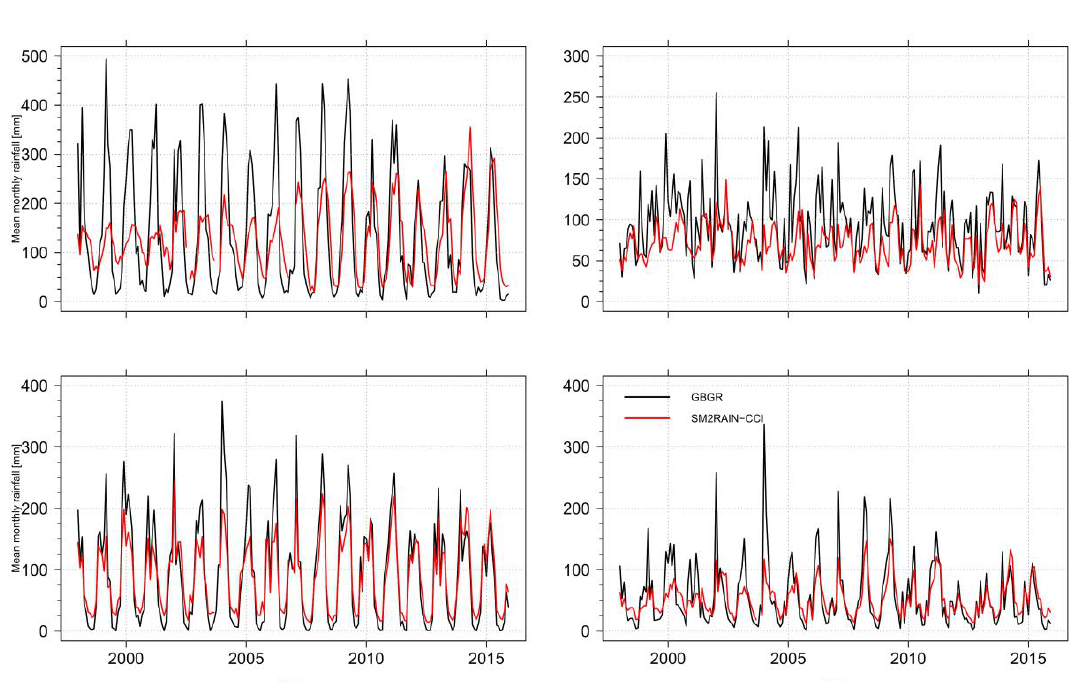
Figure 6. Mean monthly rainfall derived from the GBGR data (black line) and the 5-day SM2RAIN-CCI dataset (red line) over the biomes: ( a ) AMZ; ( b ) MAT; ( c ) CER; and ( d ) CAAT during the period 1998 – 2015.